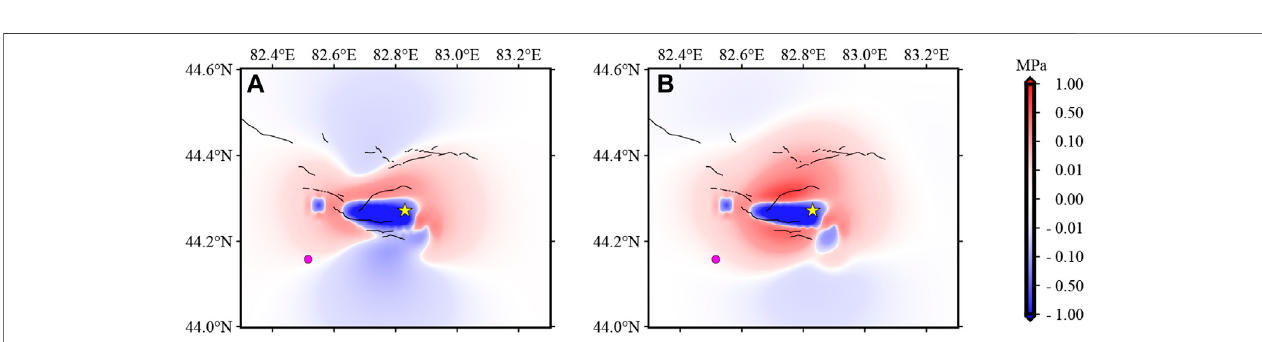
FIGURE 7 | Coseismic Coulomb stress changes of the slip distribution are constrained by IPGP data with the receiving fault of the M S 5.4 earthquake focal mechanism (strike (cid:2) 106.3 ° , dip (cid:2) 53.1 ° , andrake (cid:2) 100.0 ° )(fromLiu et al.,2021; personal communication).The M S 5.4earthquakeonOctober16, 2018,isdenoted by black circle fi lled with rose. The epicenter of the mainshock is denoted by a yellow star. Friction is (A) 0.4 or (B) 0.8.